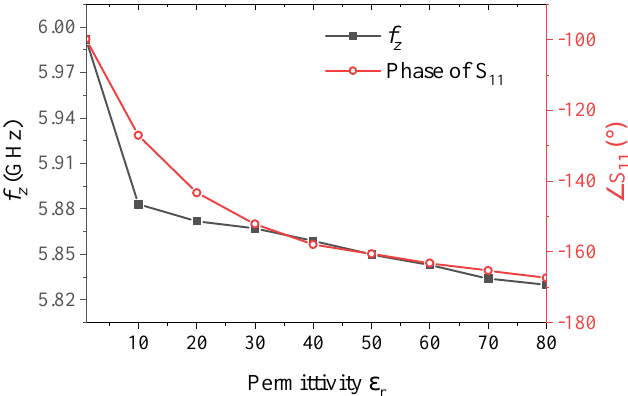
Figure 7. Comparison between frequency and phase